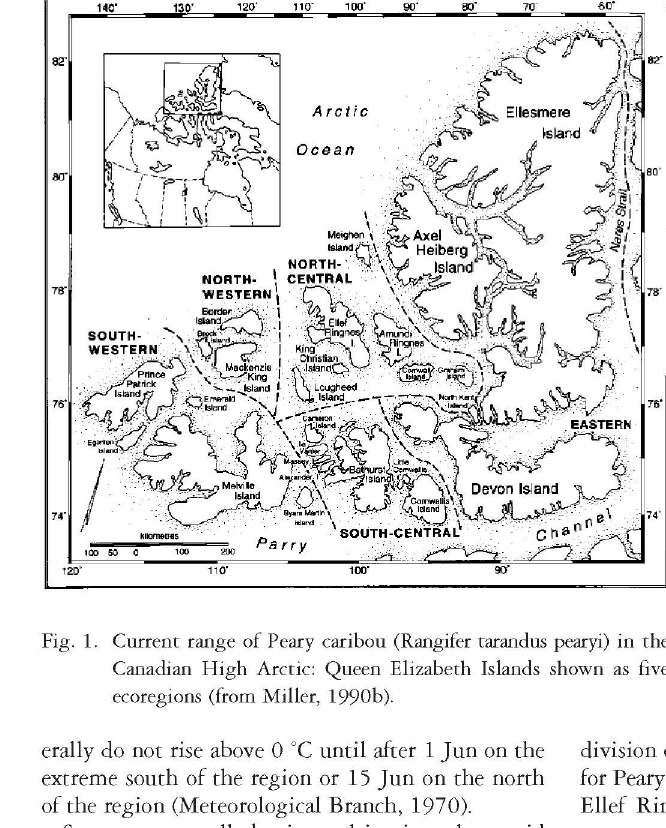
Fig. 1. Current range of Peary caribou (Rangifer tarandus pearyi) in the Canadian High Arctic: Queen Elizabeth Islands shown as five ecoregions (from Miller, 1990b). erally do not rise above 0 °C until after 1 Jun on the extreme south of the region or 15 Jun on the north of the region (Meteorological Branch,